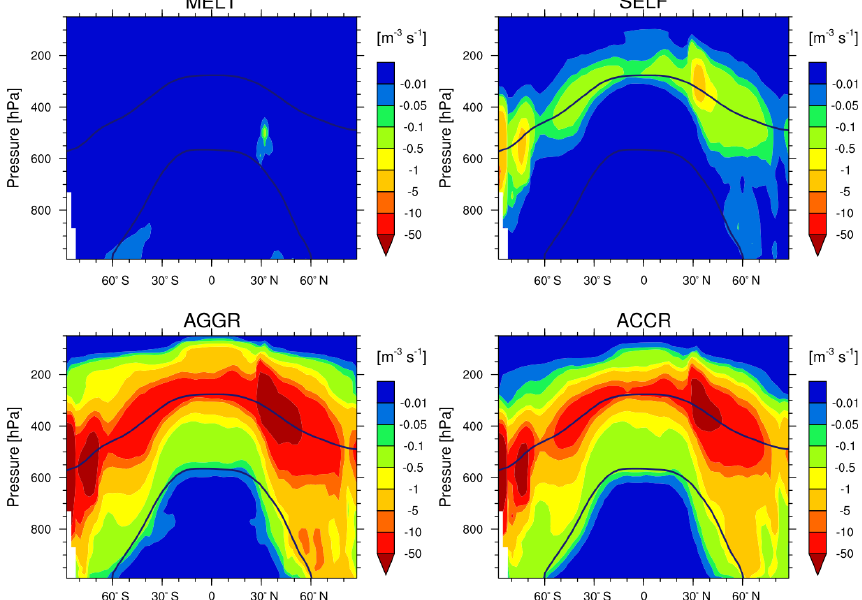
Figure 7. Annual zonal means of the tendencies associated with the IC sinks in cold clouds (REF). The isotherms at 0 and − 35 ◦ C are annual